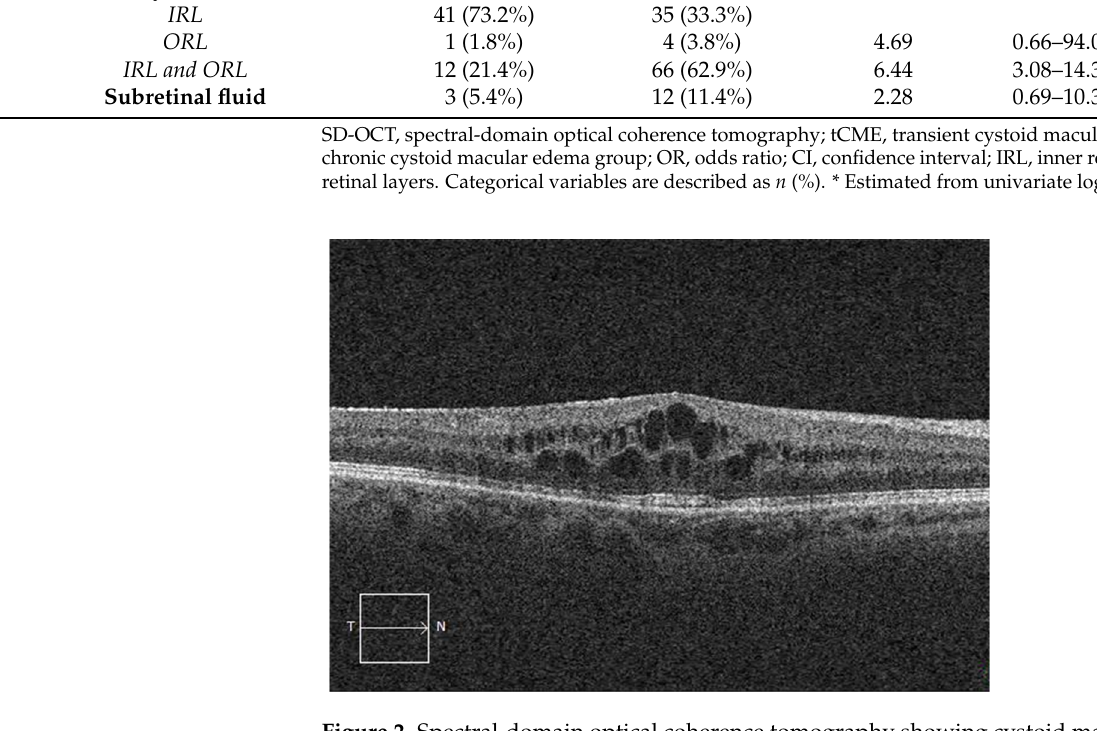
Figure 3. Spectral-domain optical coherence tomography showing cystoid macular edema in the inner retinal layers only after vitrectomy for rhegmatogenous retinal detachment. 4. Discussion This study evaluated the rate of CME 1 year after PPV for primary RRD repair in routine clinical practice. Overall, 34% of patients ( n = 163) experienced at least one episode of CME within the first year of follow-up, while the rate of CME at 12 months was 28% (97 patients). When considering a CRT greater than 320 µm associated with macular cysts in SD-OCT for the diagnosis of CME, the rate of CME at 12 months decreased to 13% [27]. These findings are consistent with previous studies, although the range of CME rates varies greatly, primarily due to a difference in CME diagnostic criteria [27,28]. A recent single-center retrospective study with a smaller sample size but similar CME diagnostic criteria showed a CME rate of 25% among patients who underwent surgery with PPV or combined PPV and scleral buckling. Lower rates were previously reported, which may be explained by discrepancies in selection criteria with the exclusion of severe cases of RRD (PVR, SO tamponade, high myopia) or in follow-up time [8,22,24]. A study conducted by Yang et al. found a higher rate (36%) of postoperative CME, probably due to the severity of RRD in the eyes included in this study (SO tamponade only) [20]. Our rate might be overestimated owing to missing data ( n = 148, 30%) at 12 months, though no imputations were carried out, and patients with good anatomical and functional outcomes were more prone to resuming their follow-up outside of our academic institution.